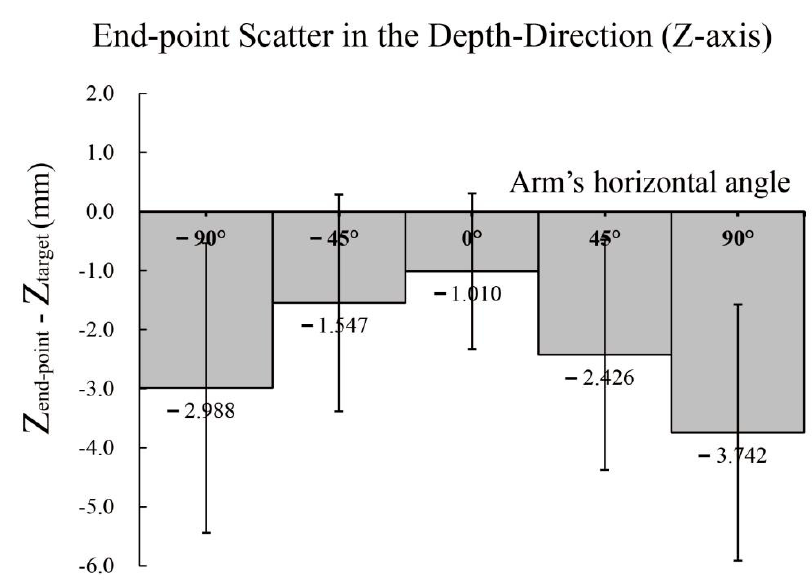
Figure 9. End-point scatter in the depth-direction.